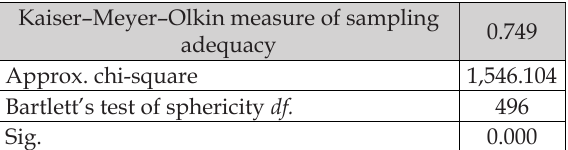
Table 5. KMO and Bartlett’s Test.